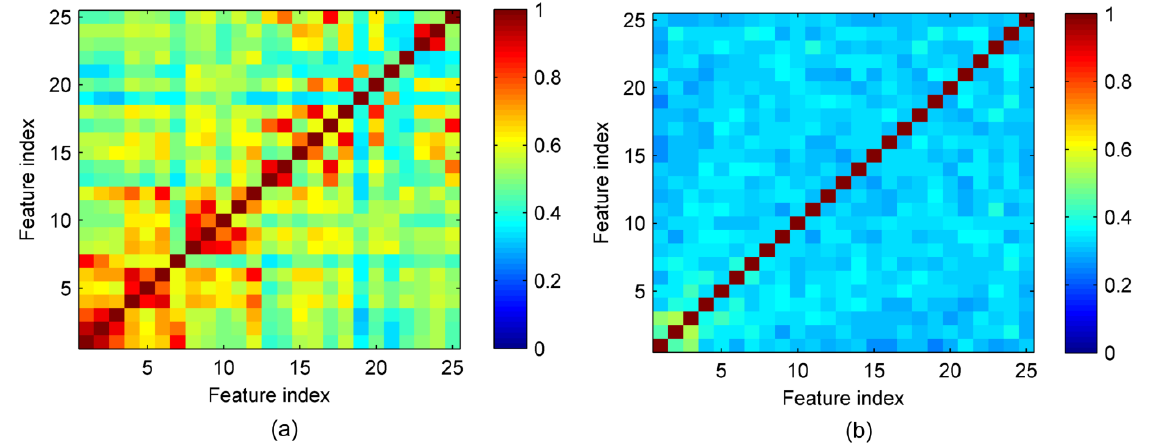
Figure 11. The distribution of mutual information between the top 25 features selected by ( a ) MIBIF and ( b ) PCA for subject av. Table 5. The highest classification accuracies and the selected feature dimension ( k ) by MIBIF and PCA for all subjects on Competition III dataset IVa (subject aa, al, av, aw, and ay).